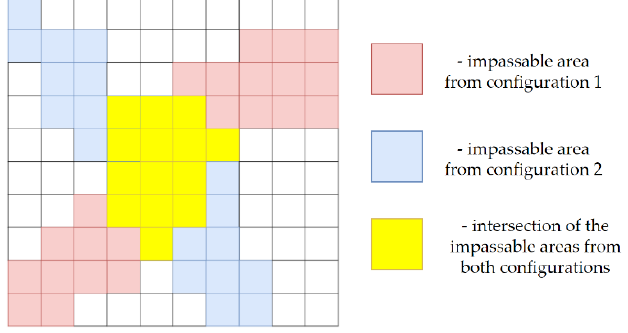
Figure 16. Illustrative figure of the intersection analysis.